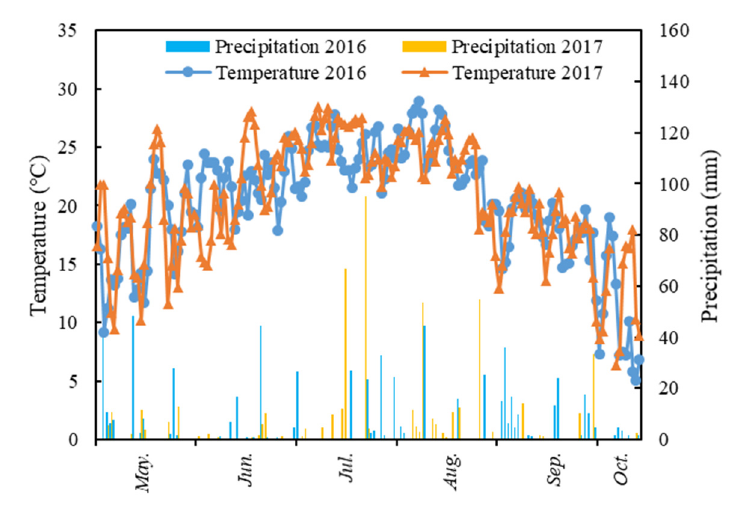
Figure 1. Daily precipitation (mm) and mean temperature ( ◦ C) during the growing season at the study site in 2016 and 2017. 138